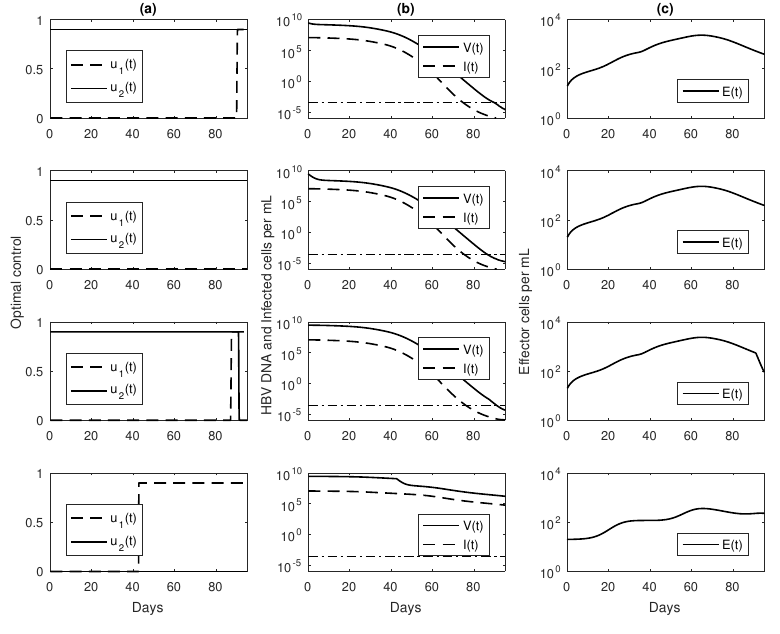
Figure 6. ( a ) Optimal evolution for controls u 1 (dashed lines) and u 2 (solid lines) as given by (15); ( b ) virus V per mL (solid lines) and infected cells I per mL (dashed lines) over time; ( c ) effector cells E per mL over time when drugs are introduced at peak virus concentration and: a 1 = a 2 = b 1 = b 2 = 1, a 3 = 0.9, f = 0.5 (top row); a 1 = a 2 = 1, a 3 = 0.9, b 1 = b 2 = 0, f = 1 (second row); a 1 = a 2 = 0, a 3 = 0.9, b 1 = b 2 = 1, f = 0 (third row); a 1 = a 2 = a 3 = 0, b 1 = b 2 = 1, f = 0 (bottom row).